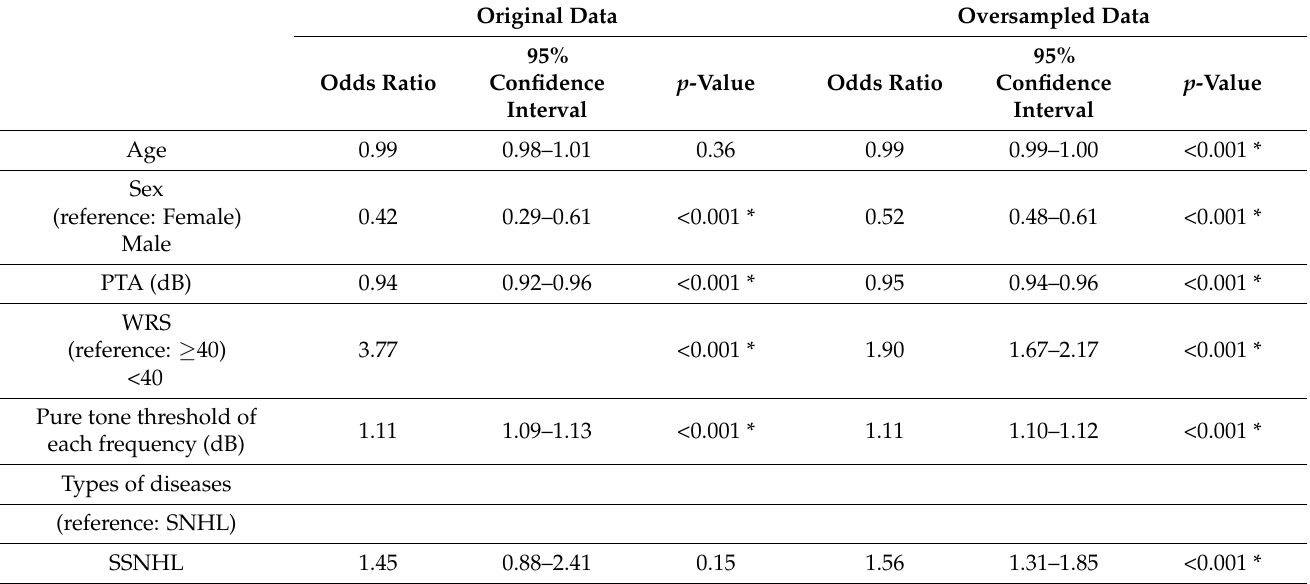
Table 2. Results of multivariate logistic regression analyses for detecting cochlear dead regions.